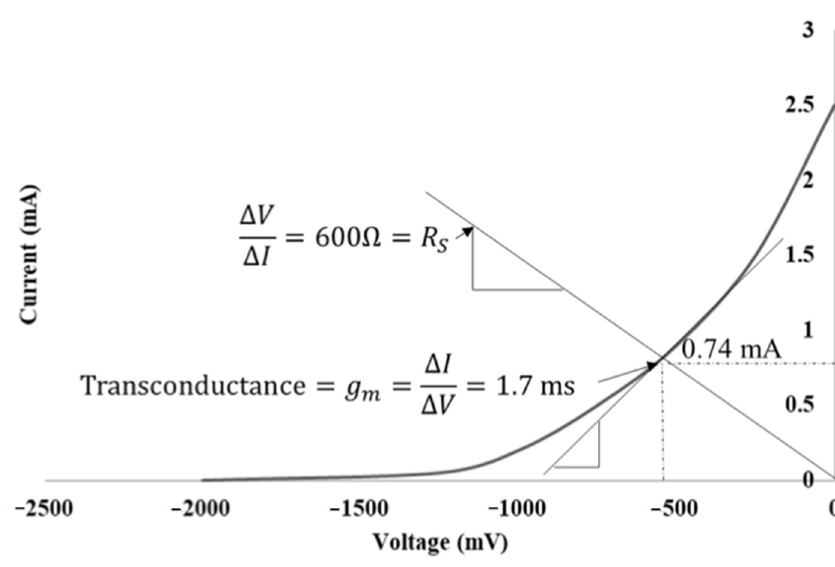
Figure 3. Transconductance curve for the FET to determine source resistance.